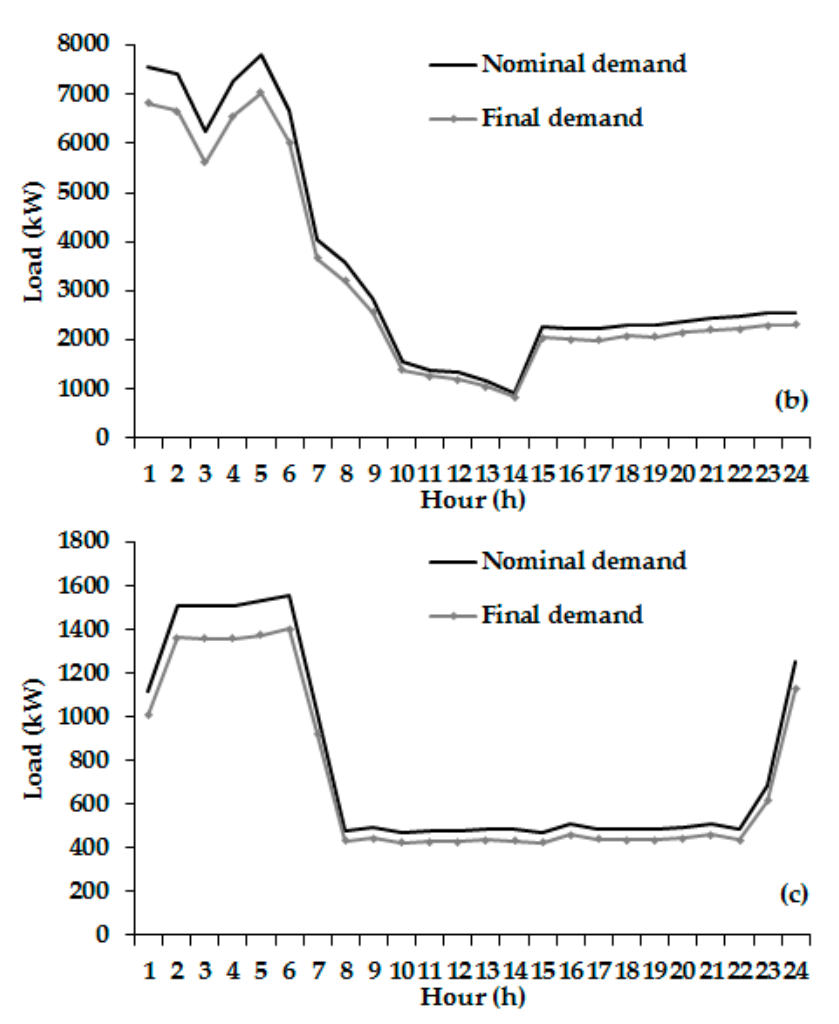
Figure 13. SC objective results with linear DR model: ( a ) Nominal price and RTP; ( b ) nominal and final demand of consumer 1 and ( c ) nominal and final demand of consumer 2.